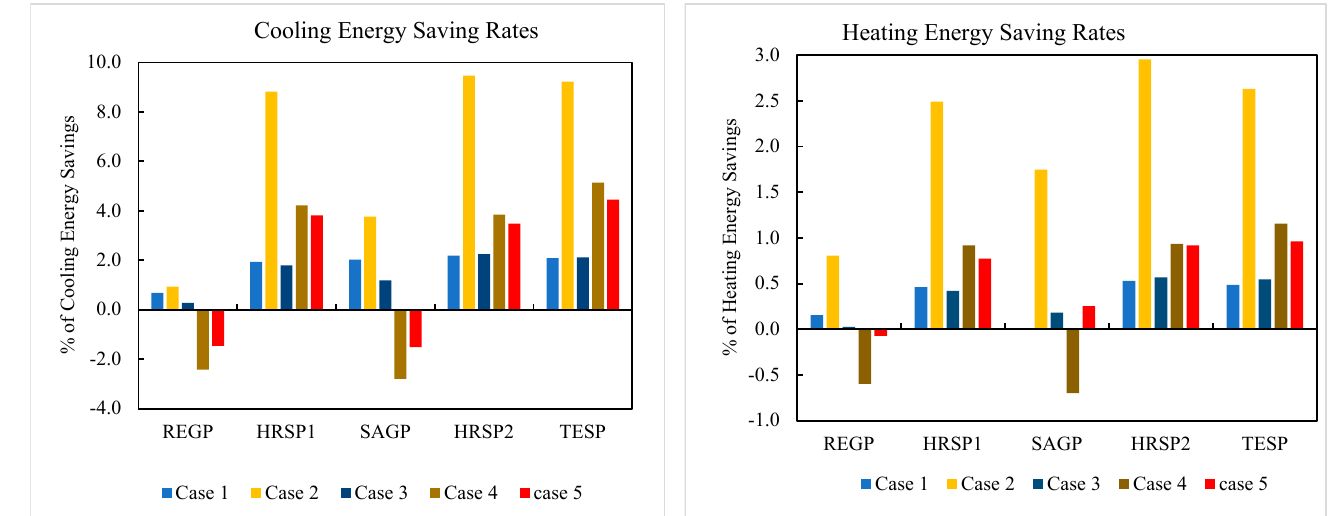
Figure 10. Cooling and heating energy savings rates.